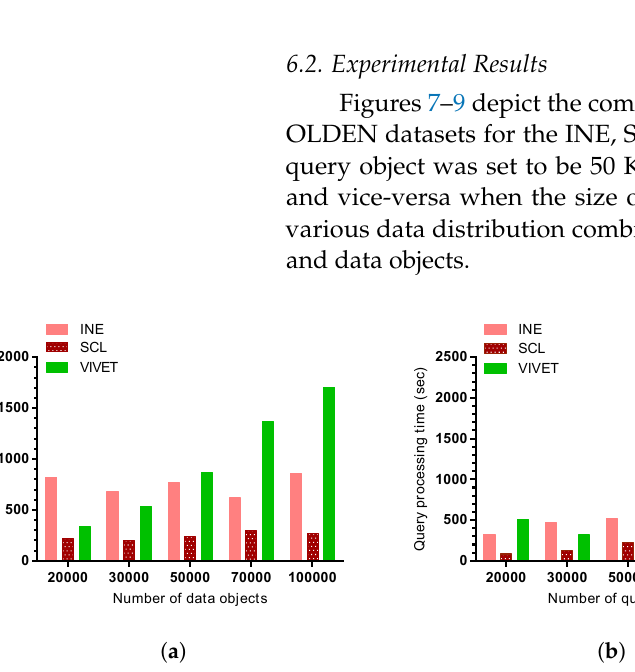
Figure 7. Comparison of INE, SCL, and VIVET for CAL: ( a ) varying D; ( b ) varying Q; ( c ) varying the distribution of objects.